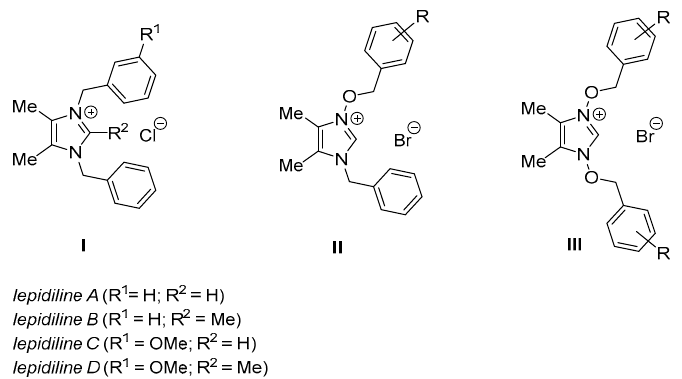
Figure 1. The structure of naturally occurring 4,5-dimethylimidazolium salts I (i.e., lepidiline alkaloids) and their 2-unsubstituted mono-alkoxy and bis-alkoxy analogues of type II and III studied in this work.